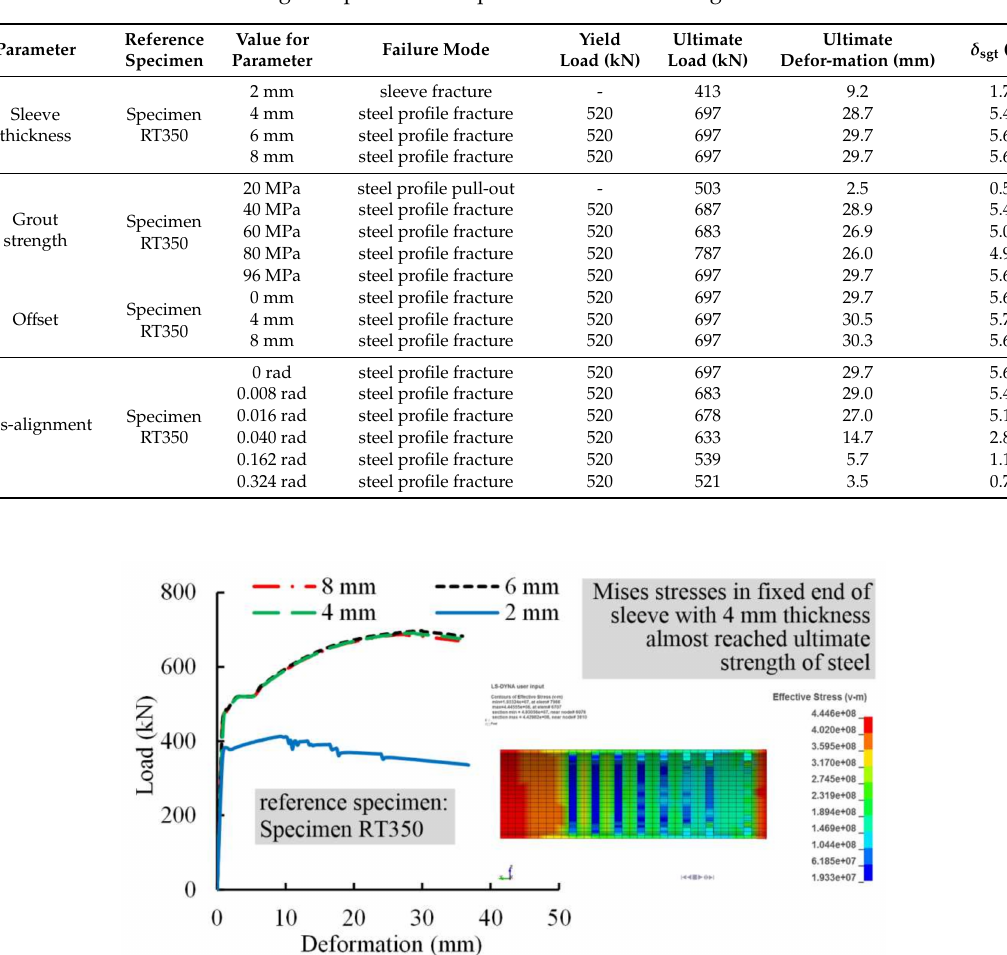
Table 7. Designed specimens for parametric studies using FEM models.